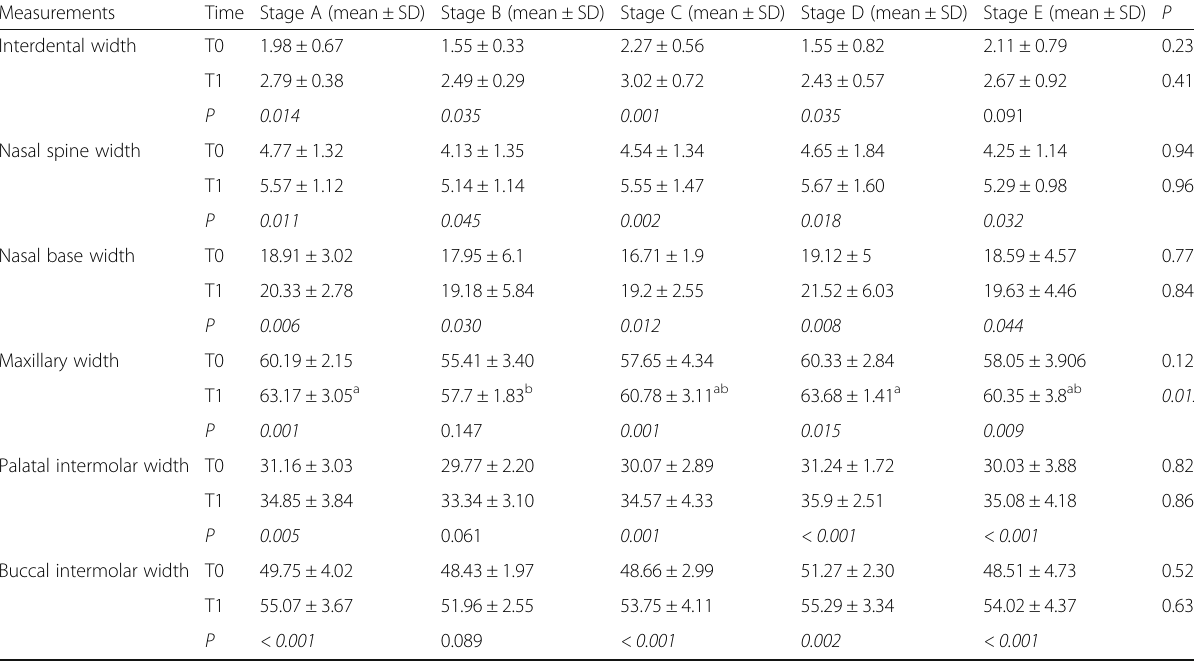
Table 2 Measurements with changes according to midpalatal suture maturation groups